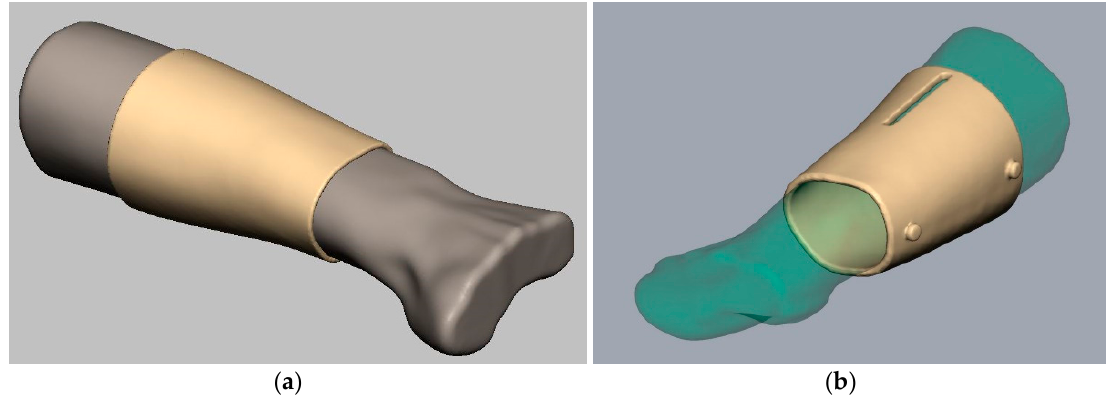
Figure 4. Initial solid obtained from the points cloud ( a ) and initial stage of the design, including the hole for the temperature sensor and closing buttons ( b ).